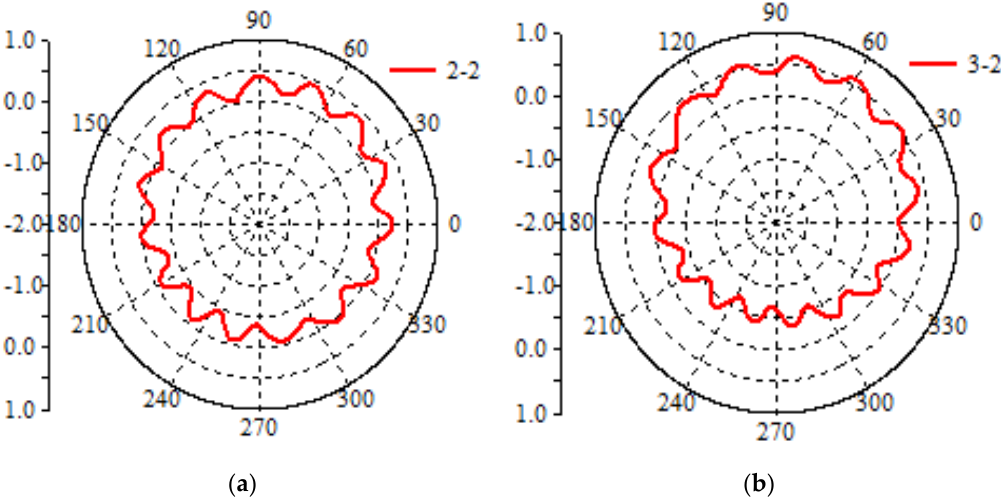
Figure 12. Polar diagram of roundness: ( a ) No.1 wheel; ( b ) No.2 wheel.